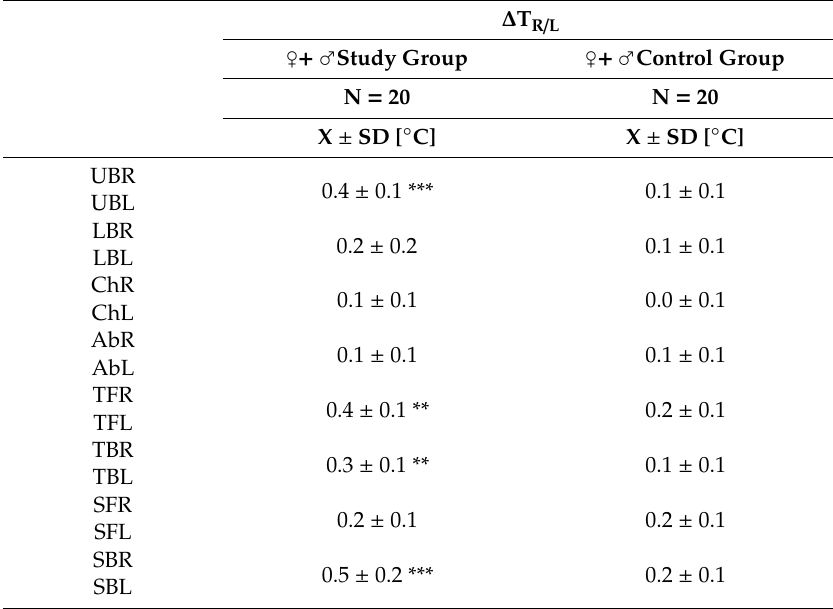
Table 6. Di ff erences in the values of mean temperature of selected areas between the right and left side of the body ( ∆ T R / L ) combined for girls and boys from the study group and the reference